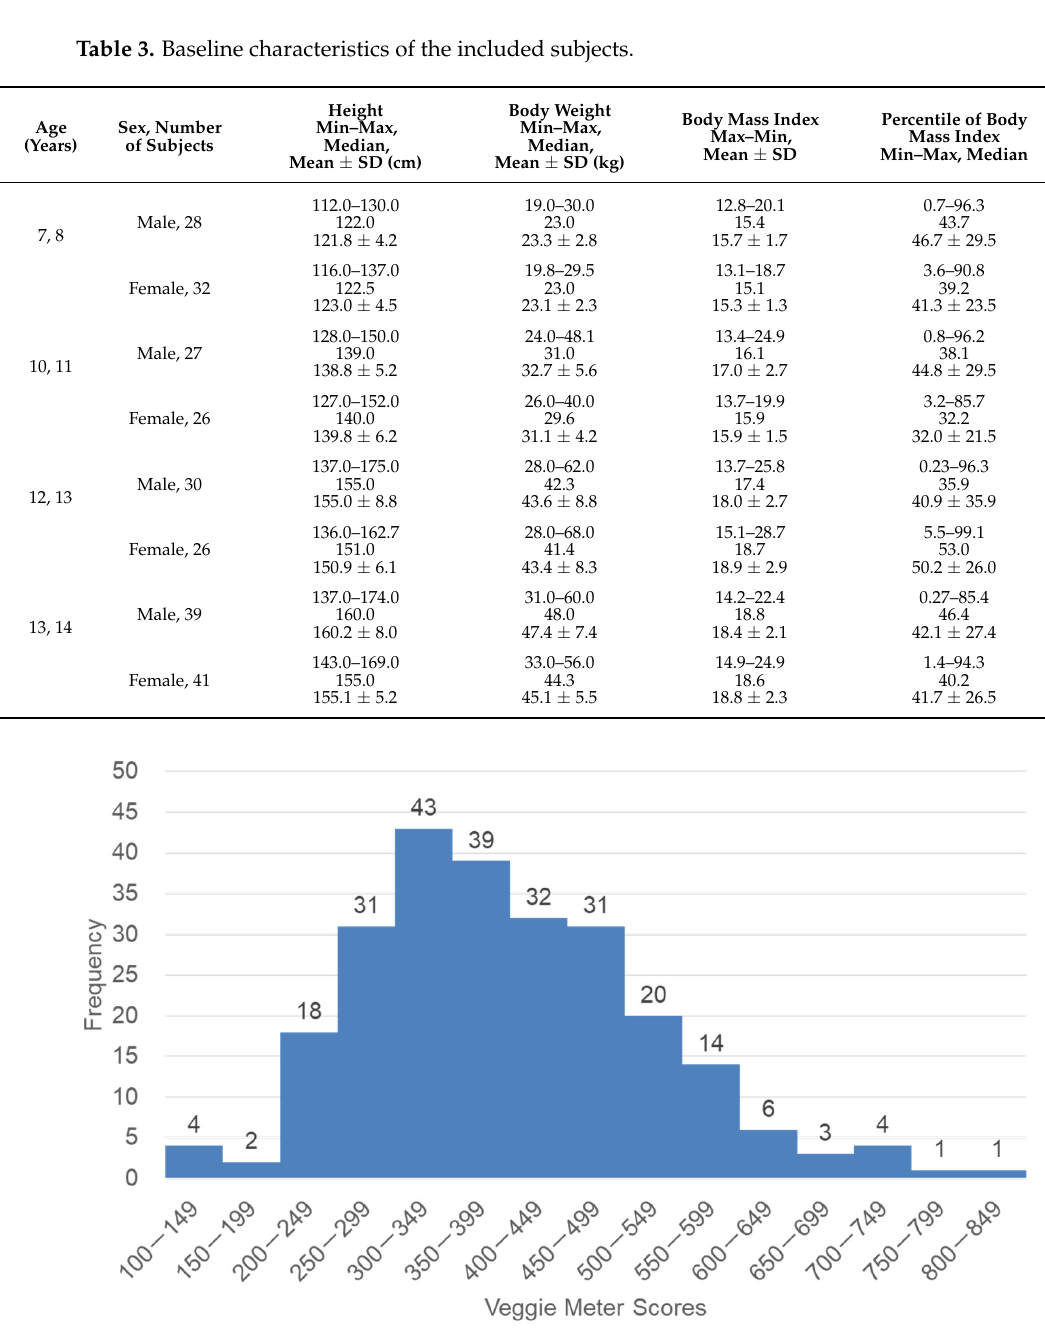
Figure 2. A histogram of the Veggie Meter scores of 249 students. The scores show a slight skew toward higher levels.